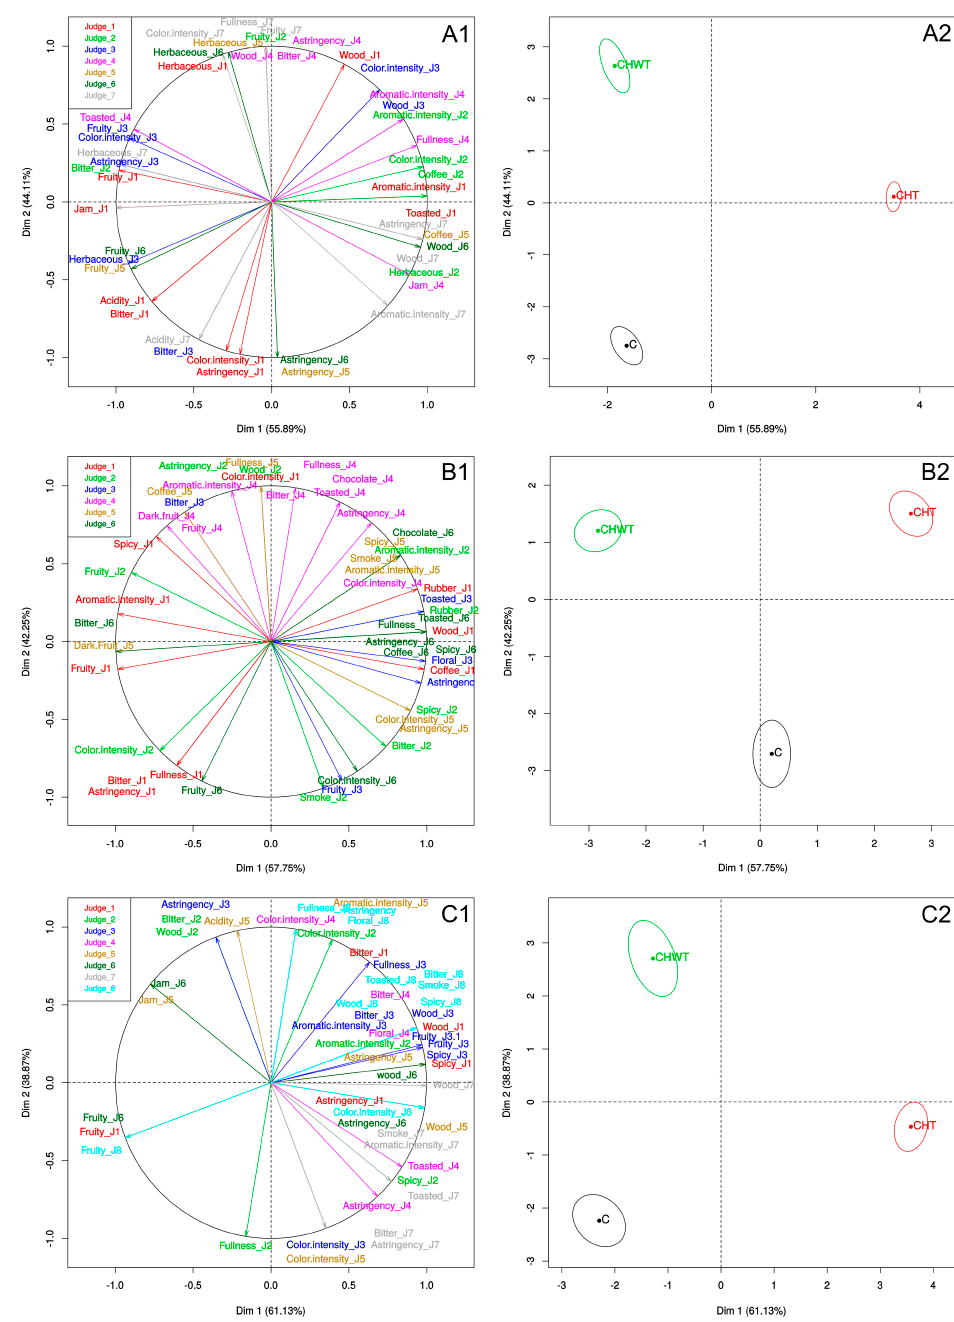
Figure 8. Multiple factor analysis (MFA) of Malbec wines (Experiment B). (1) Circle plot of MFA correlations among judges; (2) MFA consensus plot showing wine scores. Confidence ellipses indicate 95% confidence intervals. ( A ) 1M; ( B ) 2M; ( C ) 4M. C, control; CHWT, untoasted vine-shoot chips; CHT, toasted vine-shoot chips; 1M, 30 days; 2M, 60 days; 4M, 120